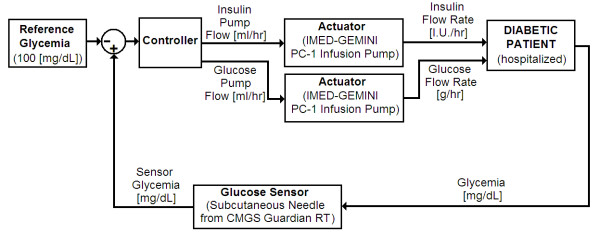
System diagram of the "Automatic Insulin Infusion System" (AIIS) for Inpatient Treatment(see text). Glucose concentration measured by the subcutaneous sensor is compared to the reference glycemia (100 mg/dL). The result becomes the input for the controller. If the result is either normoglycemia (90-120 mg/dL) or hyperglycemia (> 120 mg/dL), or if the glycemia is rising too fast, then the controller signals the insulin pump, that releases insulin solution at a particular rate (international units per hour). On the other hand, if the input to the controller reflects a hypoglycemia (i.e., glycemia < 60 mg/dL), or if the glycemia, albeit being within normal range, is falling too fast, then the controller signals the glucose pump. Every five minutes, the subcutaneous glucose sensor submits the results of a new glucose estimate to the input of the controller, and the whole process is repeated.